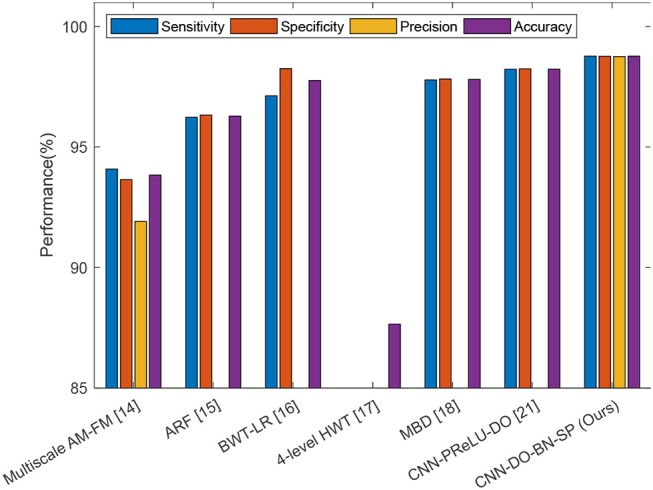
Comparison plot.